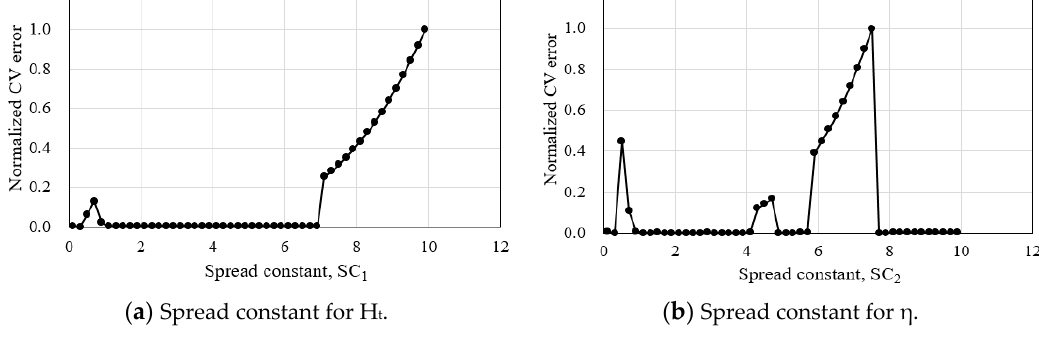
( a ) Spread constant for H t . ( b ) Spread constant for η .